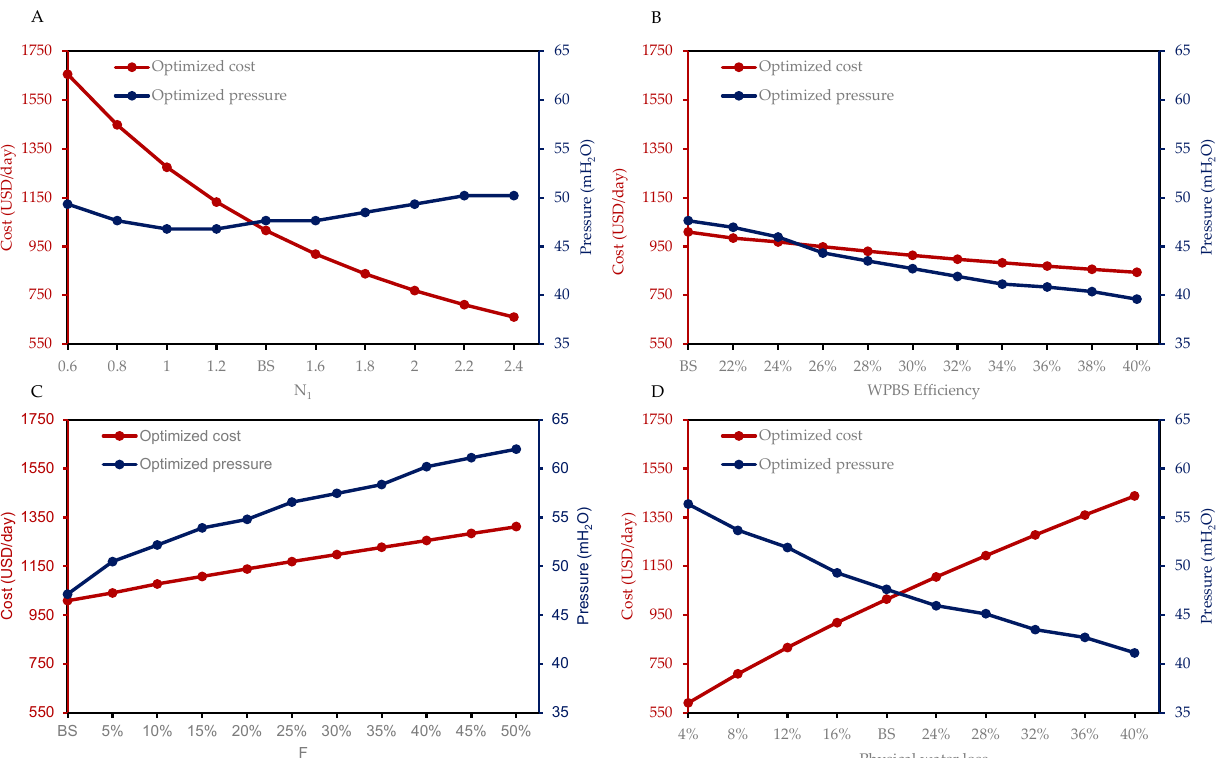
Figure 9. Sensitivity of optimized pressure and optimized cost to the ( A ) leakage exponent, ( B ) WPBS efficiency, ( C ) parameter F, and ( D ) physical water loss.